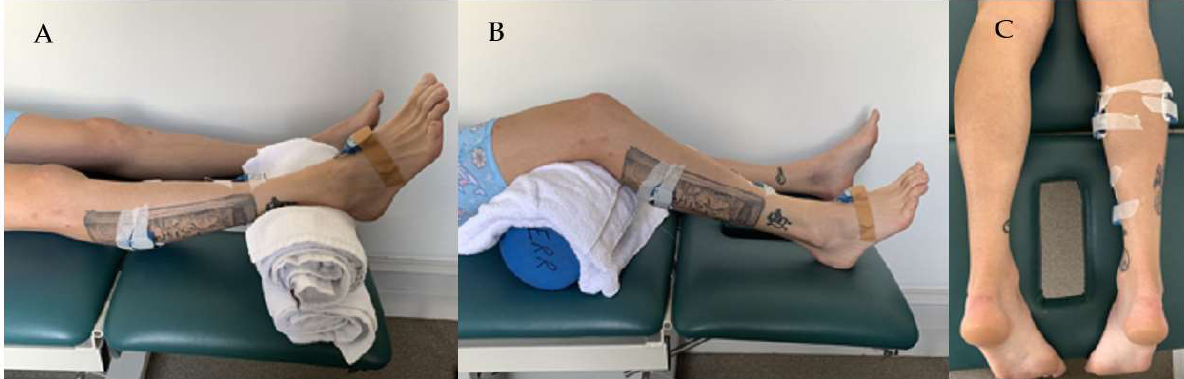
Figure 2. Participant position and sensor setup during the Tardieu spasticity assessment of the Gastrocnemius ( A ) and Soleus ( B ). EMG sensors positions are illustrated in ( C ).